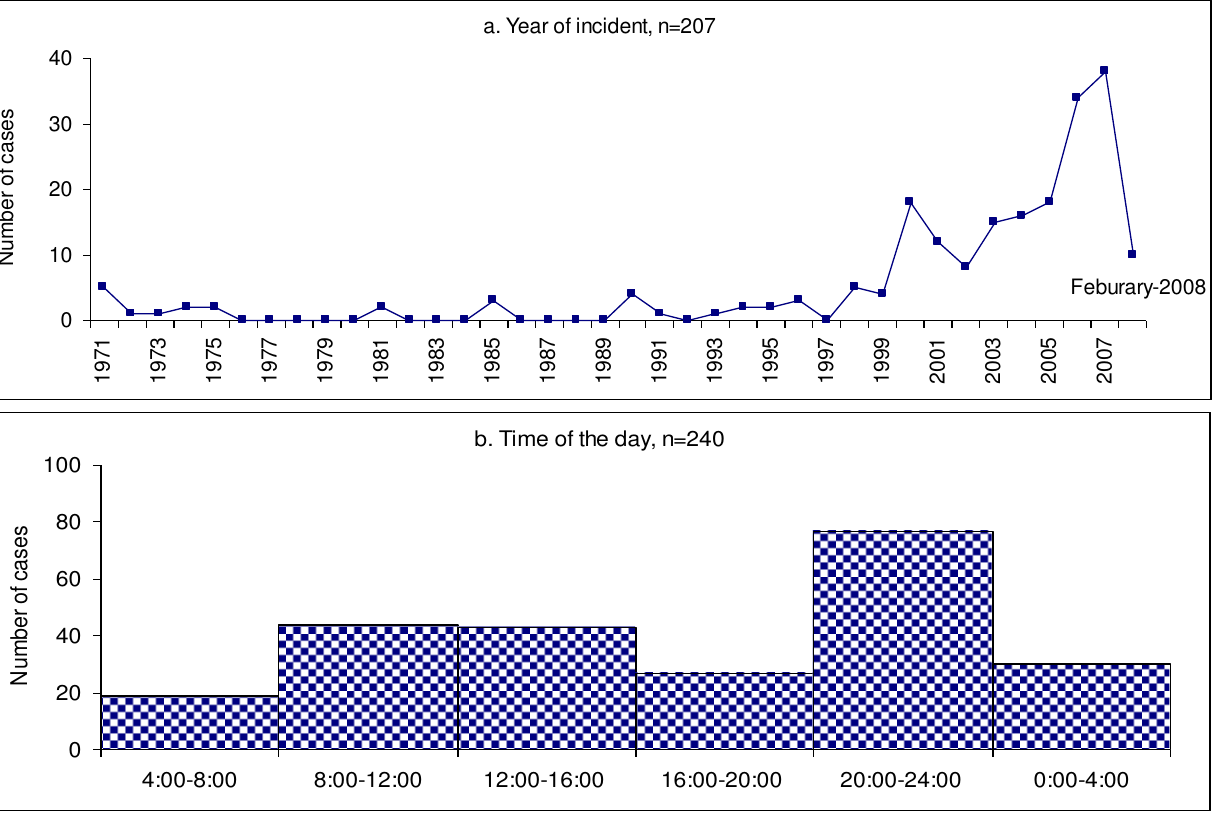
Height and weight were measured for 228 participants (Table 2) (eight participants missed the measurement). BMI is defined as an individual's body weight divided by the square of his or her height. The mean BMI was 20.7 with a SD of 3.0 (range 13-29) for males and was 22.2 with a SD of 3.9 (range 12.9-31.2) for females. We used the cut-off values for being overweight (23.0 ≤ BMI<27.0)